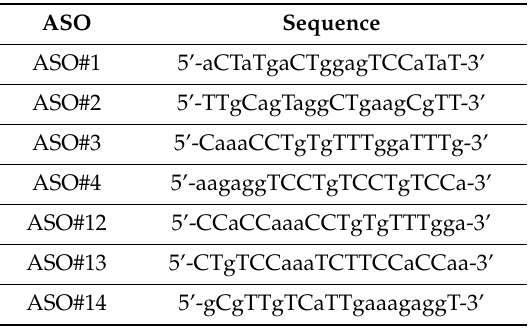
Table 1. Nucleotide sequence of